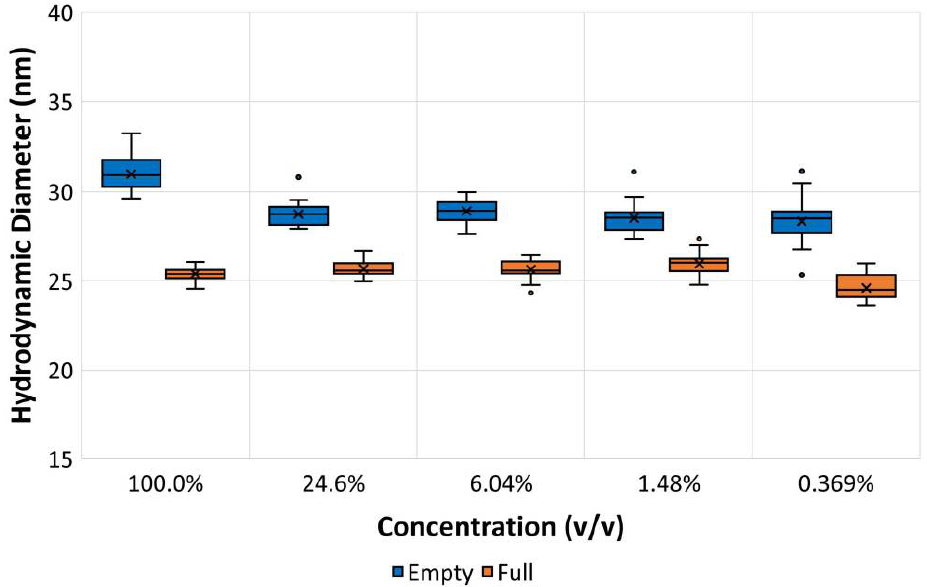
Figure 10. Hydrodynamic sizes of full and empty rAAV5 samples measured at a range of dilutions expressed in volume-by-volume percentages using MADLS measurements.